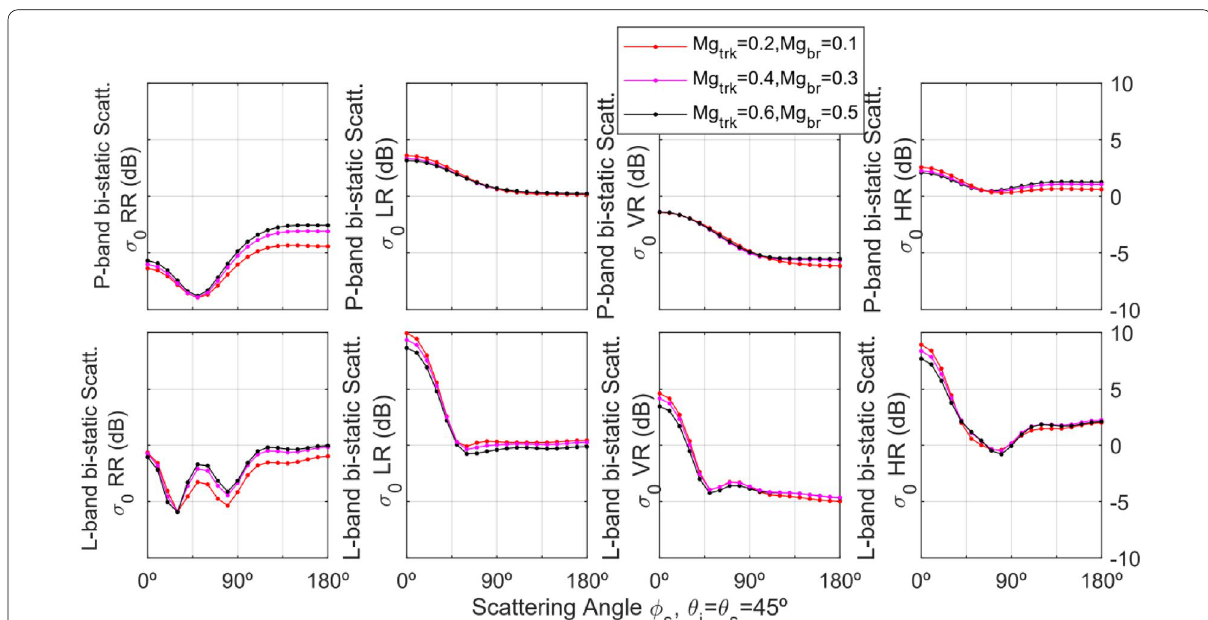
Fig. 14 Bistatic scattering at P and L bands for various polarizations, and the 3 different scenarios with different vegetation water content. θ i θ s 45°, ϕ s from 0° to = =